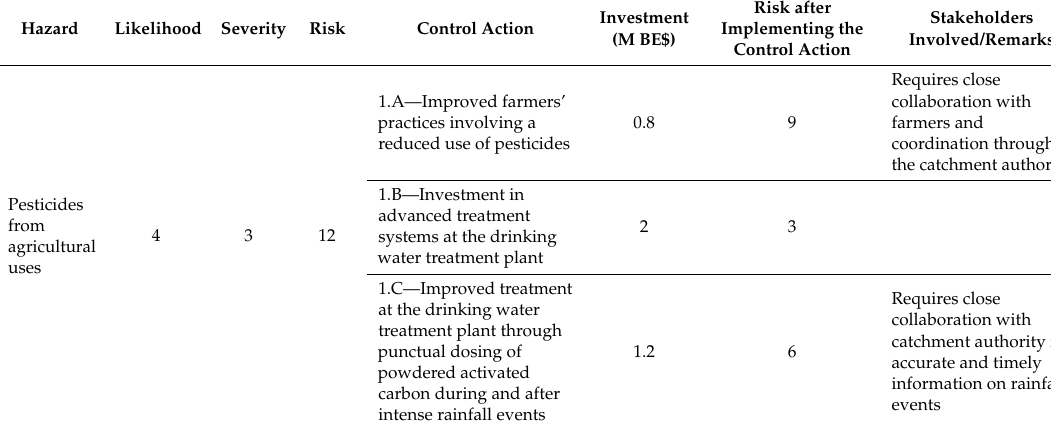
Table 2. Example of one high-risk hazard and possible control actions identified through the WSP.